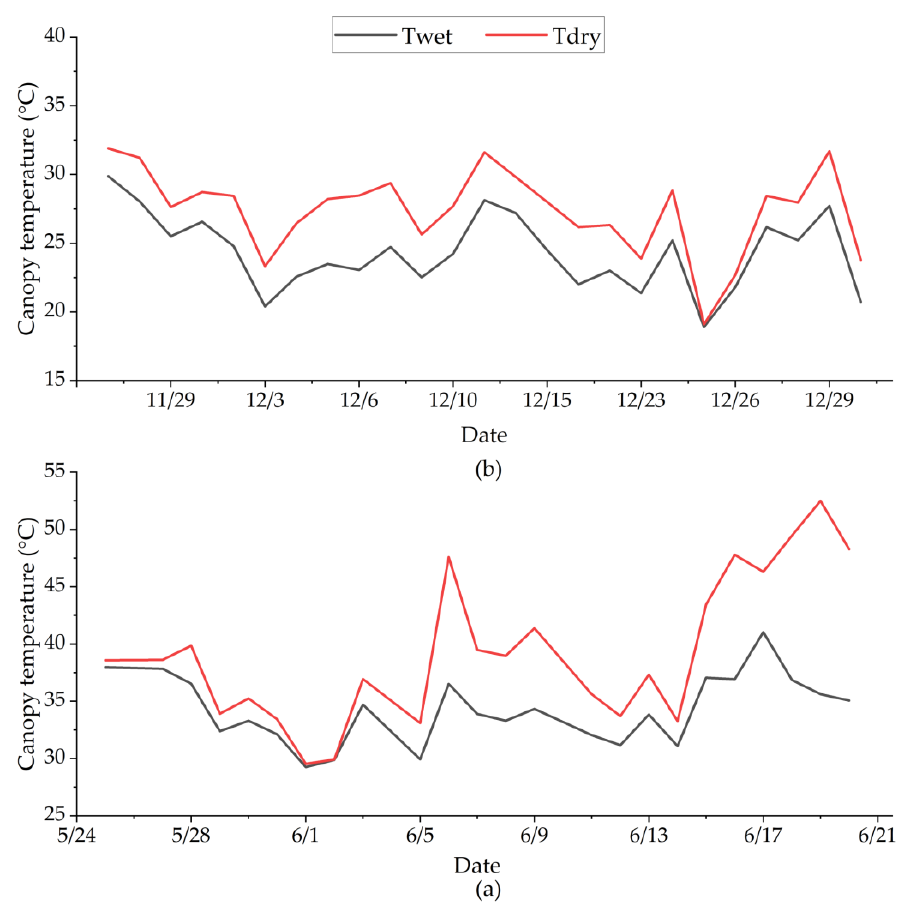
Figure 5. Average values of T wet and T dry for E1 ( a ) from 27 November to 31 December and E2; ( b ) from 25 May to 20 June 2021.